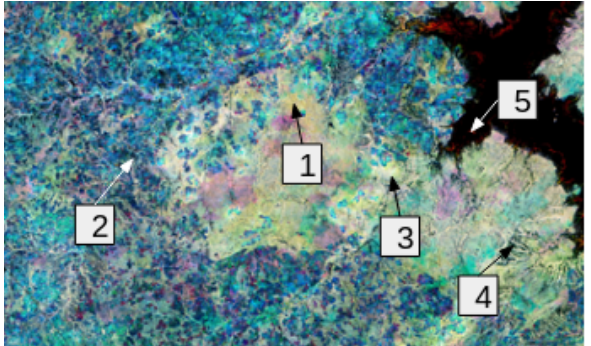
Figure 3: Sample sites of different landcover types from a 3 Pe- riod Timescan image of the Niassa Pastoral Zone